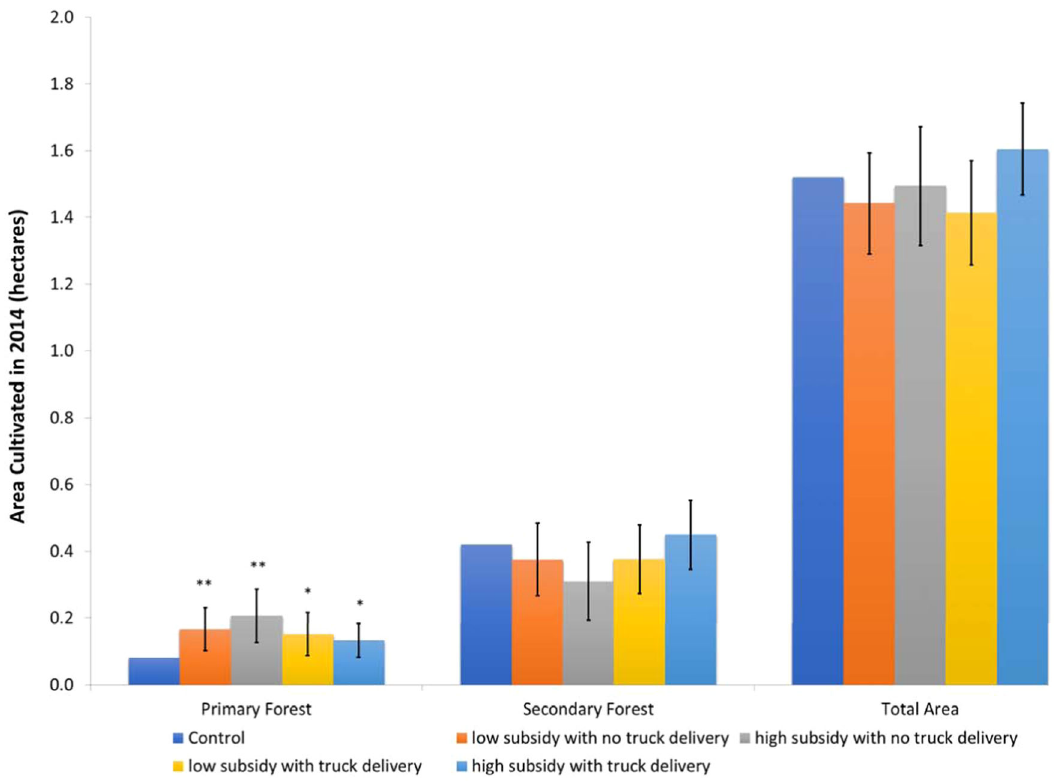
Fig. 4 | Effect of intervention on area cultivated in 2014 by land use in the previousseason,householdlevel. Source:Follow-upsurveywave2014.Estimates based on n =904 households living in the n =92 independent villages included in the experiment. Note: Dependent variable: area cultivated in 2014, in hectares, by type of land use on these plots in the previous season. All outcome variables were measured as the inverse hyperbolic sine transformation of the area in hectares. Each bar represents the ordinary least square (OLS) point estimates, and vertical lines show a 90% con fi dence interval for the difference between treatment and